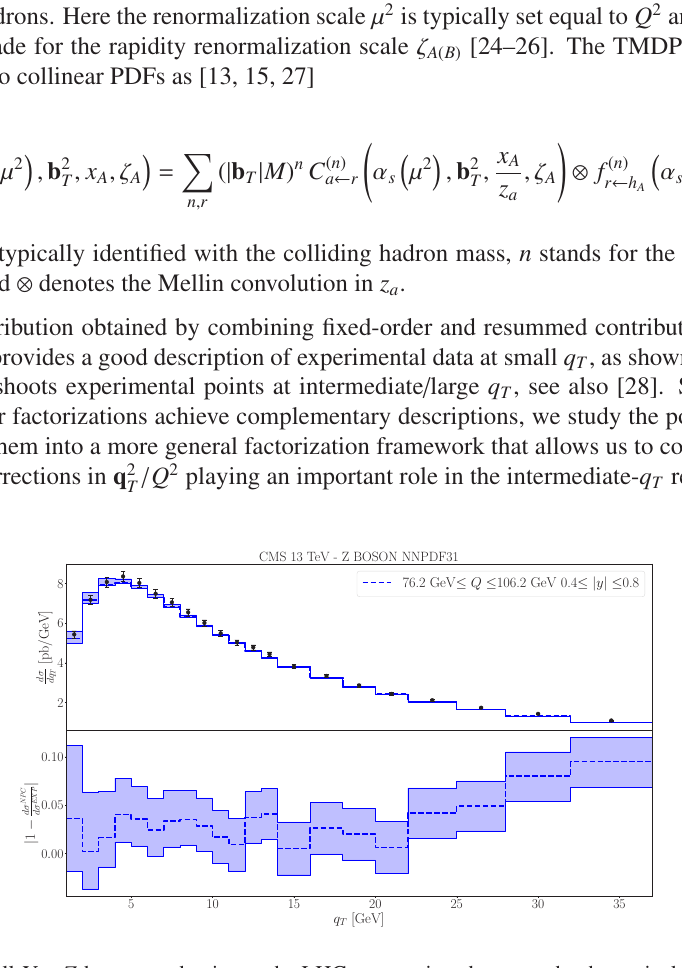
Figure 1. Drell-Yan Z -boson production at the LHC: comparison between the theoretical prediction in TMD factorization at NNLO + NNLL accuracy [23] and CMS experimental data